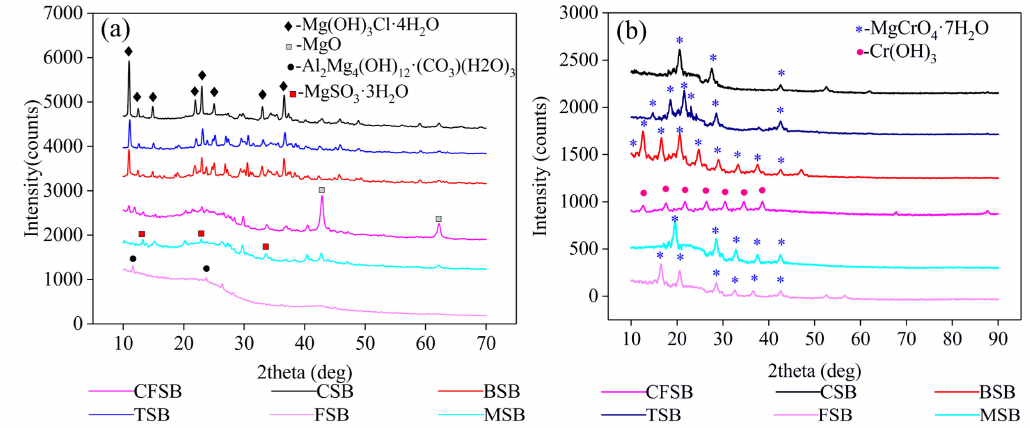
Figure 4. XRD analysis of the six biochars ( a ) before and ( b ) after adsorption of